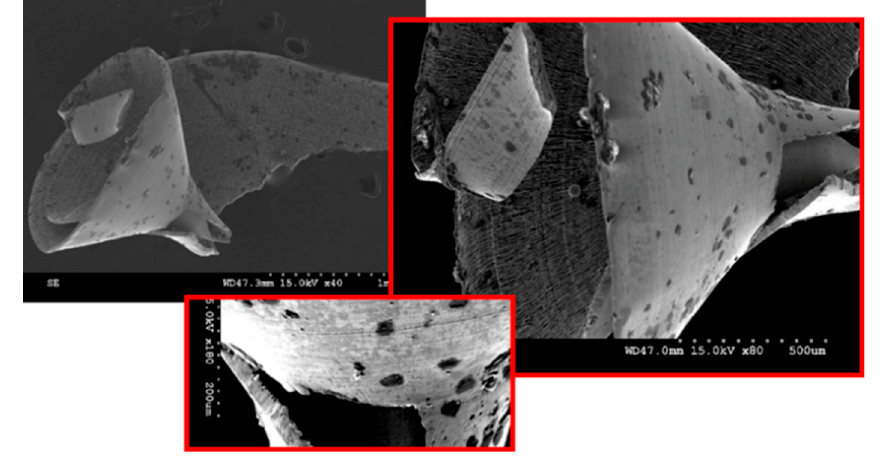
Figure 21. Cutting tool chips of the 51 HRC samples (0.05 mm/rev, 40 m/min).